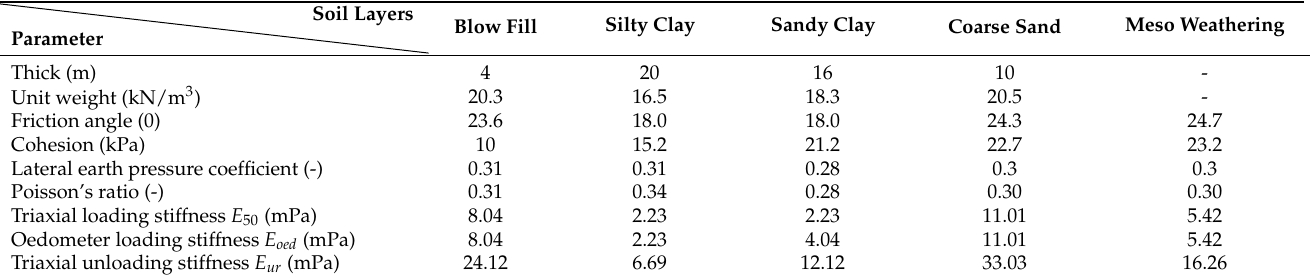
Table 3. Soil layer engineering parameters.